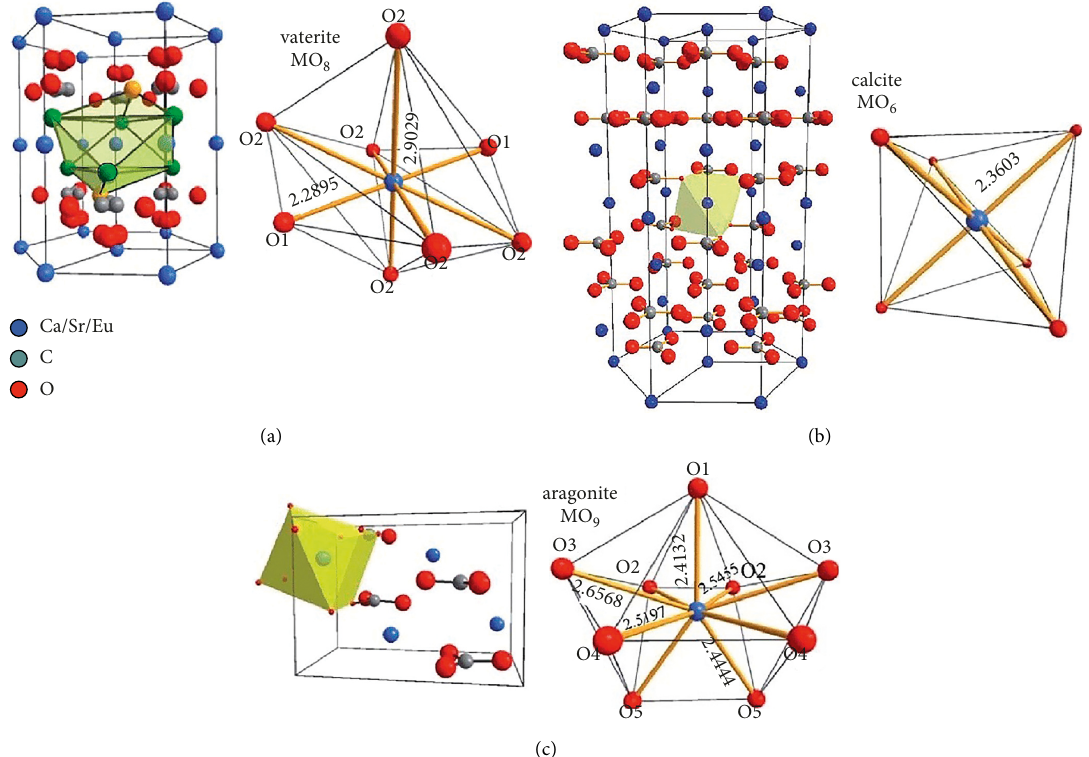
Figure 1: Allotropic structural cells of calcium carbonate: (a) vaterite, (b) calcite, and (c) aragonite. The neighboring environment of the cation and the cation-oxygen distances are also shown (copyright: Royal Society of Chemistry 2014, order number 1198792 [19]).